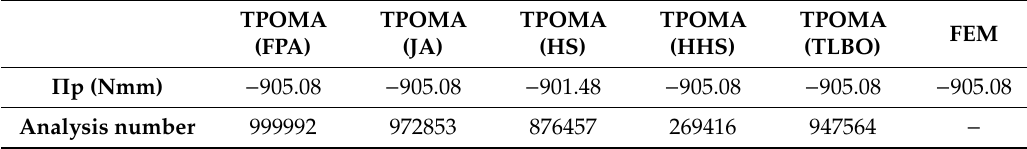
Figure 6. Mathematical models with 32 members and 25 nodes. Table 3. Total potential energy results for the system with 144